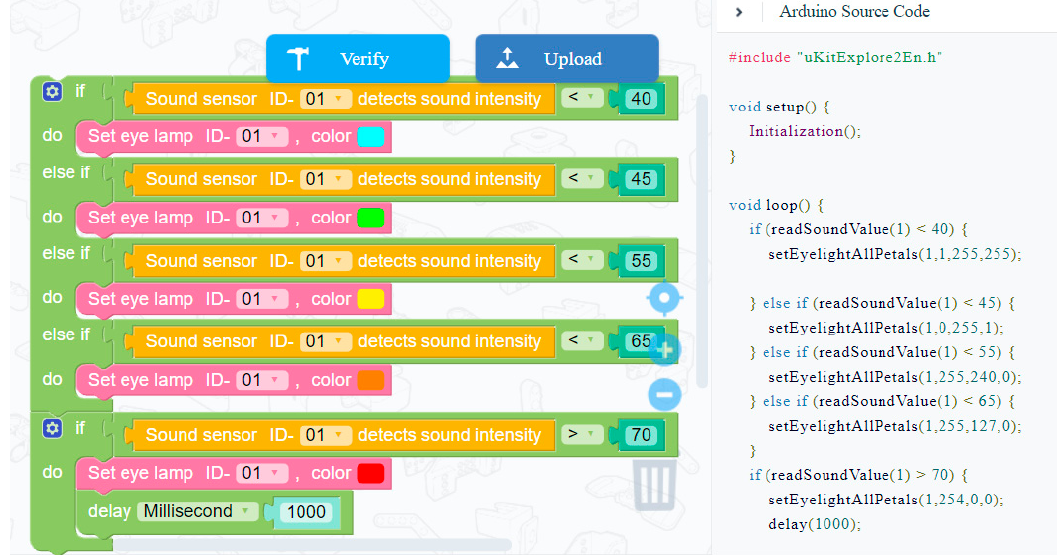
Figure 3. The code of noise detector design.